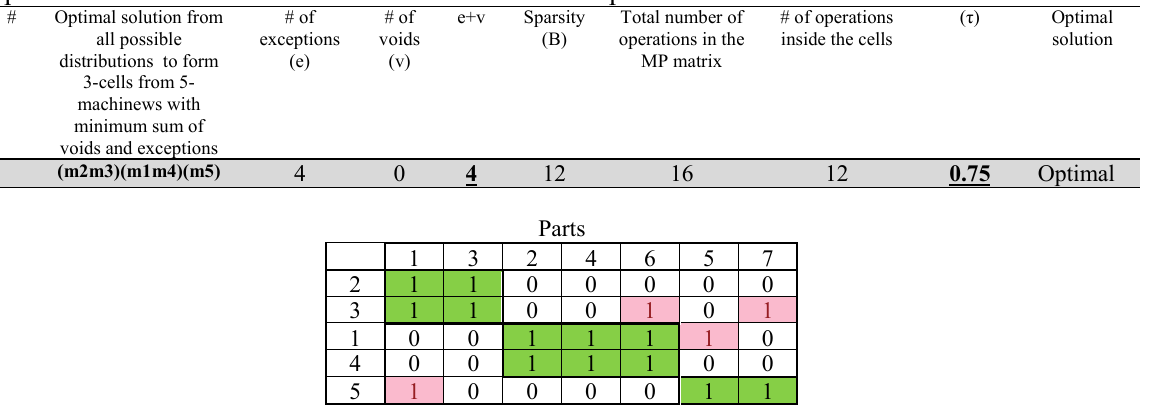
Fig. 10. Optimal 3-cell solution with minimum sum of voids and